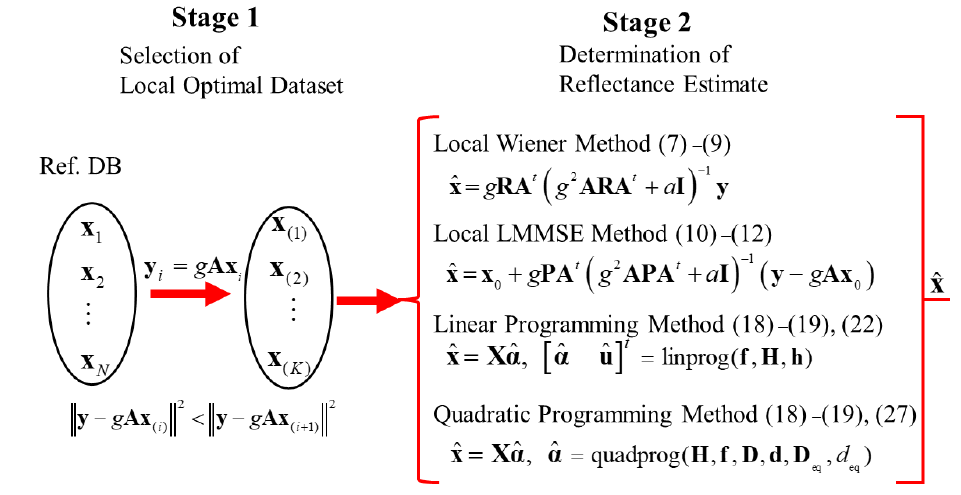
Figure 3. Overall flow of the proposed methods for estimating spectral reflectance in two stages.